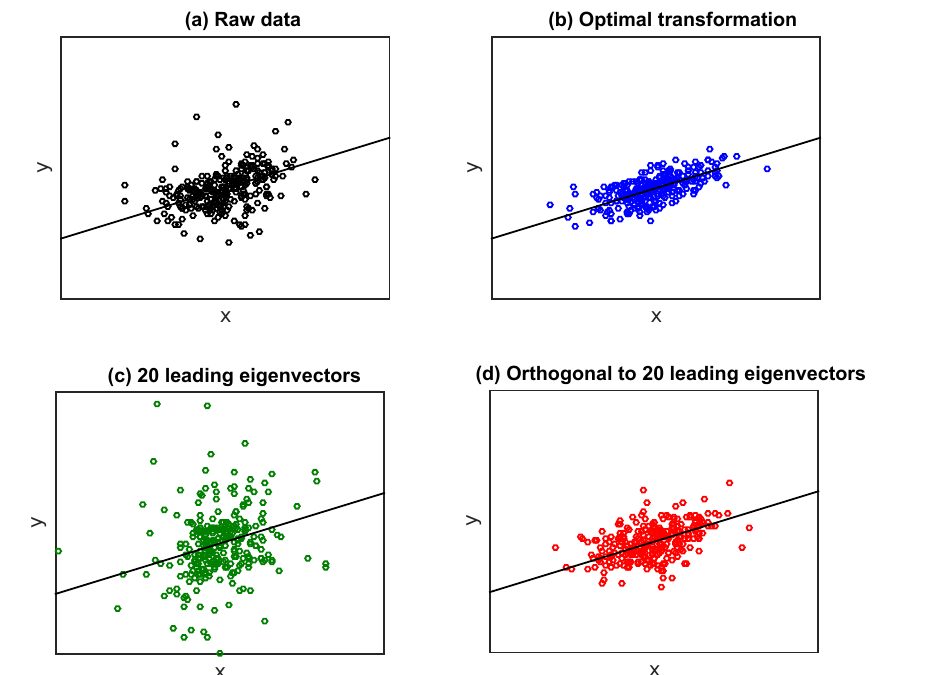
Figure 2. (a) Scatter plot of one realization of the raw data ( y , x ) using the simulation test bed of Section 4: the observation vector y is plotted on the vertical axis and the first column vector x 1 of the matrix x is plotted on the horizontal axis. (b) Same as (a) for the transformed data T y and Tx using the optimal transformation matrix T = V (cid:49) − − 1 2 r V (cid:48) T r = V r (cid:49) r on the leading eigenvectors, with r with r =